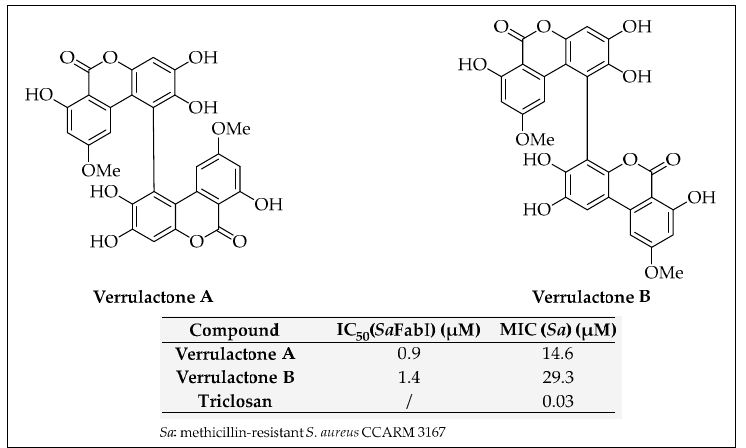
Figure 39. Structure and in vitro activities of verrulactones A and B [167,168].